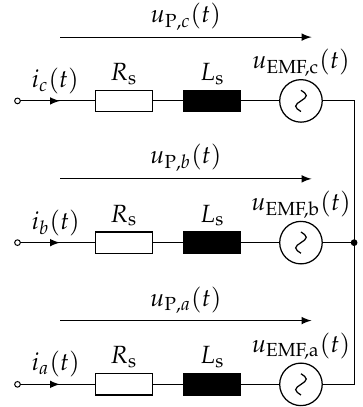
Figure 9. Circuit diagram of the converter